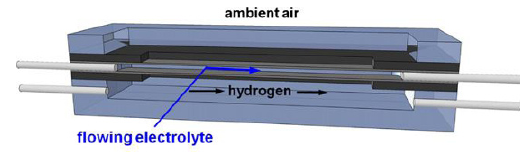
Figure 2. Alkaline microfluidic fuel cell system with gaseous hydro- gen and air reactants [11], Copyright Elsevier 2010.